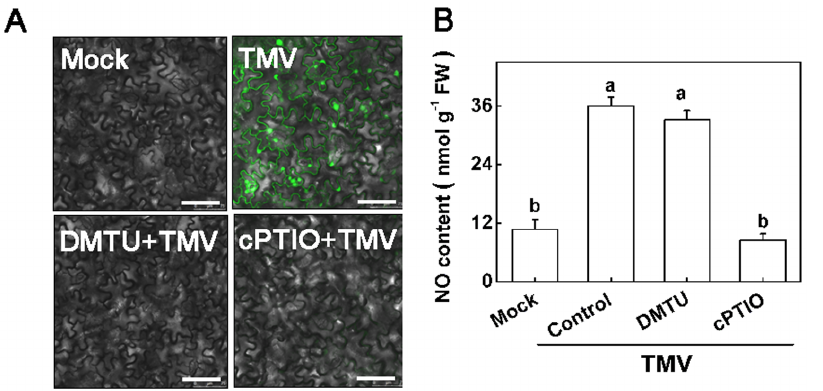
Figure 4. Effects of scavengers of H 2 O 2 and NO on TMV-induced H 2 O 2 and NO accumulation in Nicotianatabacum . The non-inoculated upper leaves were subjected to DMTU (H 2 O 2 scavenger) or cPTIO (NO scavenger) pretreatment 12 hours before TMV inoculation. A . Representative H 2 O 2 visualization using H 2 DCF-DA and a confocal microscope in which H 2 O 2 exhibited green fluorescence. All images are at the same magnification and the white scale bar indicates 75 m m. B . NO assayed with Griess reagent. The results are expressed as the mean 6 SD, n =4. The letters indicate significant differences between the treatments ( P , 0.05).